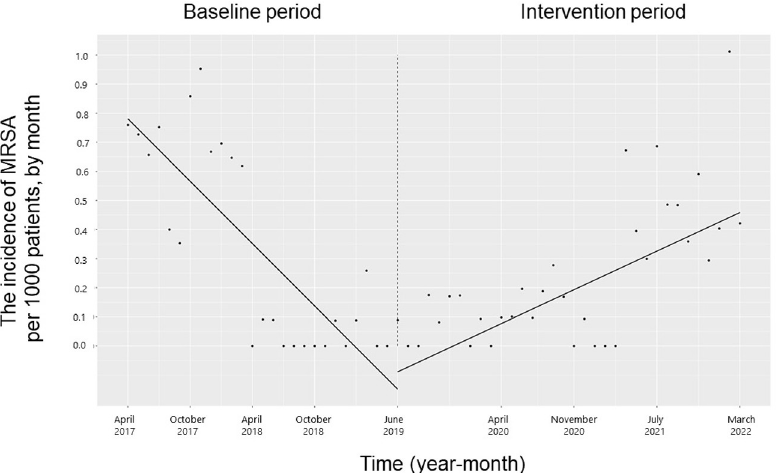
Fig 11. Trends in the incidence of methicillin-resistant Staphylococcus aureus (MRSA) per 1000 patients, by month, during the pre-intervention period (Phase 1) and interventional period (Phases 2–4). Each dot refers to MRSA per 1000 patients each month, and the slope is based on linear regression in the four phases: Phase 1 (pre- intervention period from April 1, 2017, to May 31, 2019); Phase 2 (review of clinical pathways from June 1, 2019, to March 31, 2020); Phase 3 (establishing an infectious disease (ID) consultation service and implementing the antimicrobial stewardship program from April 1, 2020, to June 30, 2021); and Phase 4 (educational lecture and pop-up displays for oral antimicrobials from July 1, 2021, to March 31, 2022).